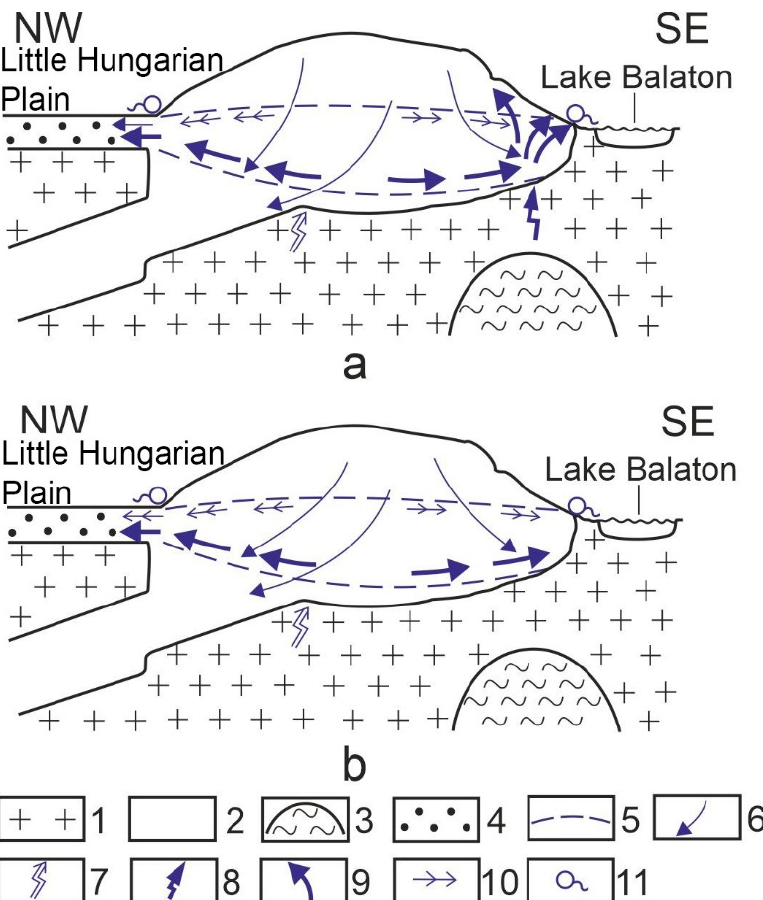
Figure 6. Ways that groundwater is heated up in the Bakony Region (based on [19,20]). Legend: ( a ) Initial state, ( b ) Present state, 1. Non-karstic rock, 2. Carbonate rocks, 3. Melt, 4. Basin sediment, 5. Groundwater level, 6. Infiltration, 7. Groundwater heating up as a result of high heat flux, 8. Heat flow from the magma chamber, 9. Heating up and ascending flow of groundwater, 10. Groundwater flow, 11. Karst spring.